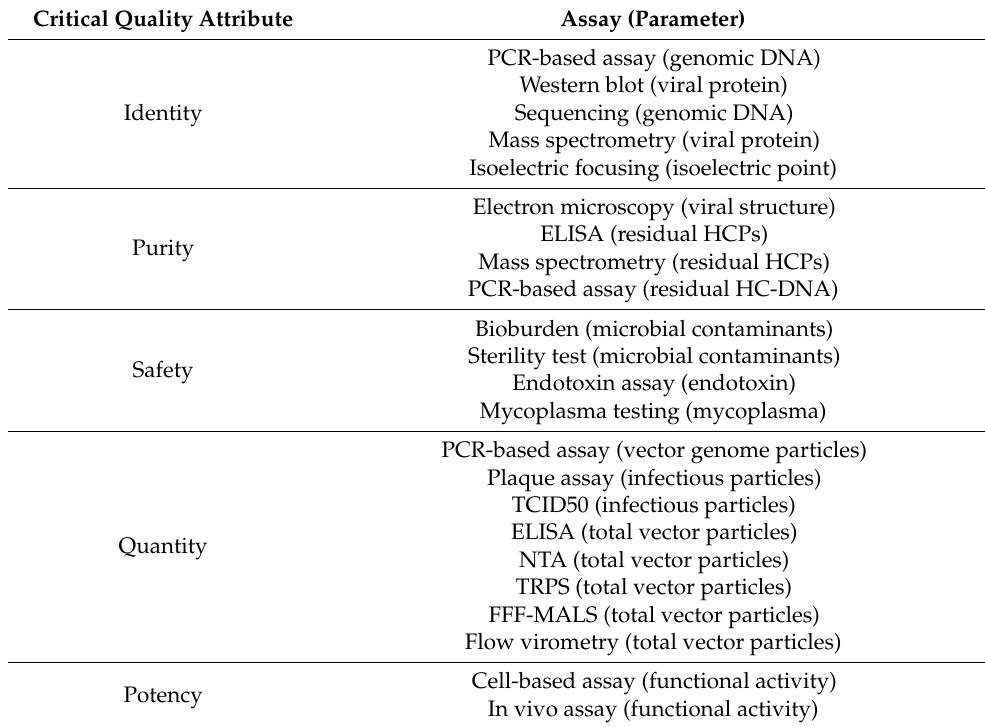
Table 3. Analytical assays most commonly used in-process and with end product in enveloped viral vector and vaccine manufacturing (adapted from Moleirinho et al.